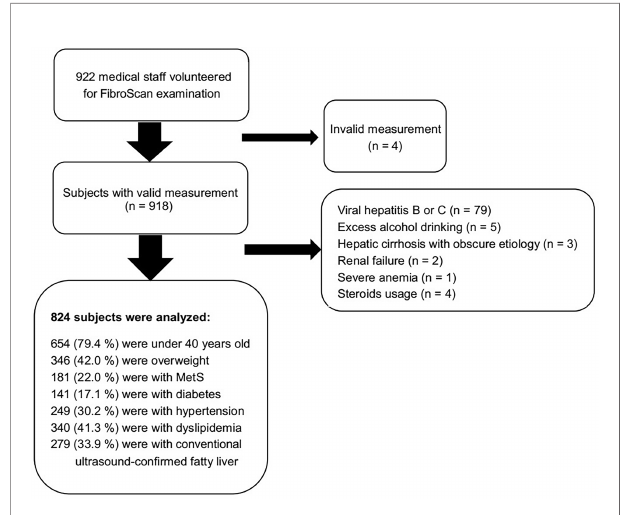
FIGURE 1 | Flow chart of inclusion/exclusion and composition of the included